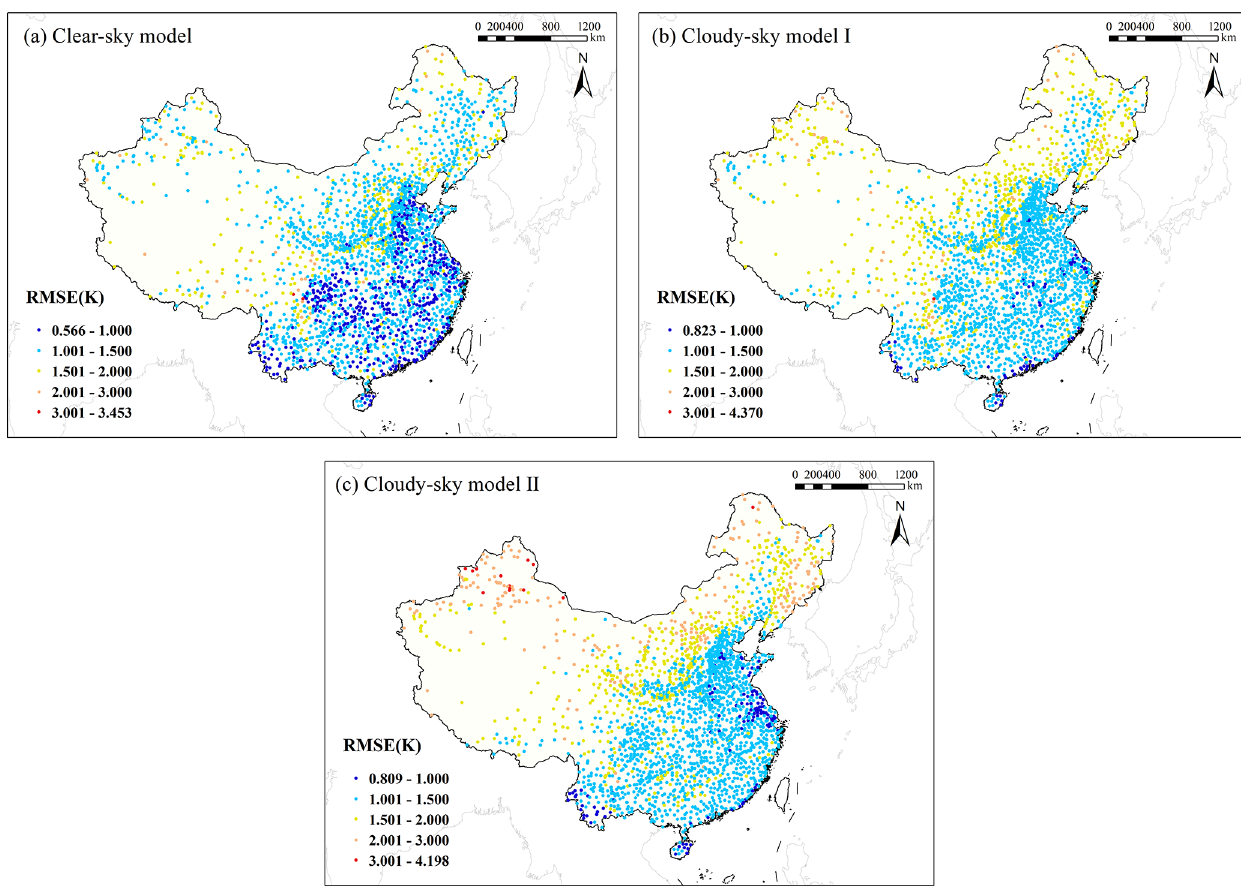
Figure 11. RMSE spatial distribution of stations for three models.